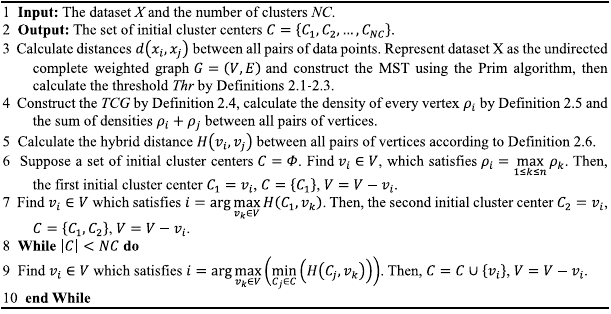
Algorithm 1. Algorithm of the proposed AIMK.